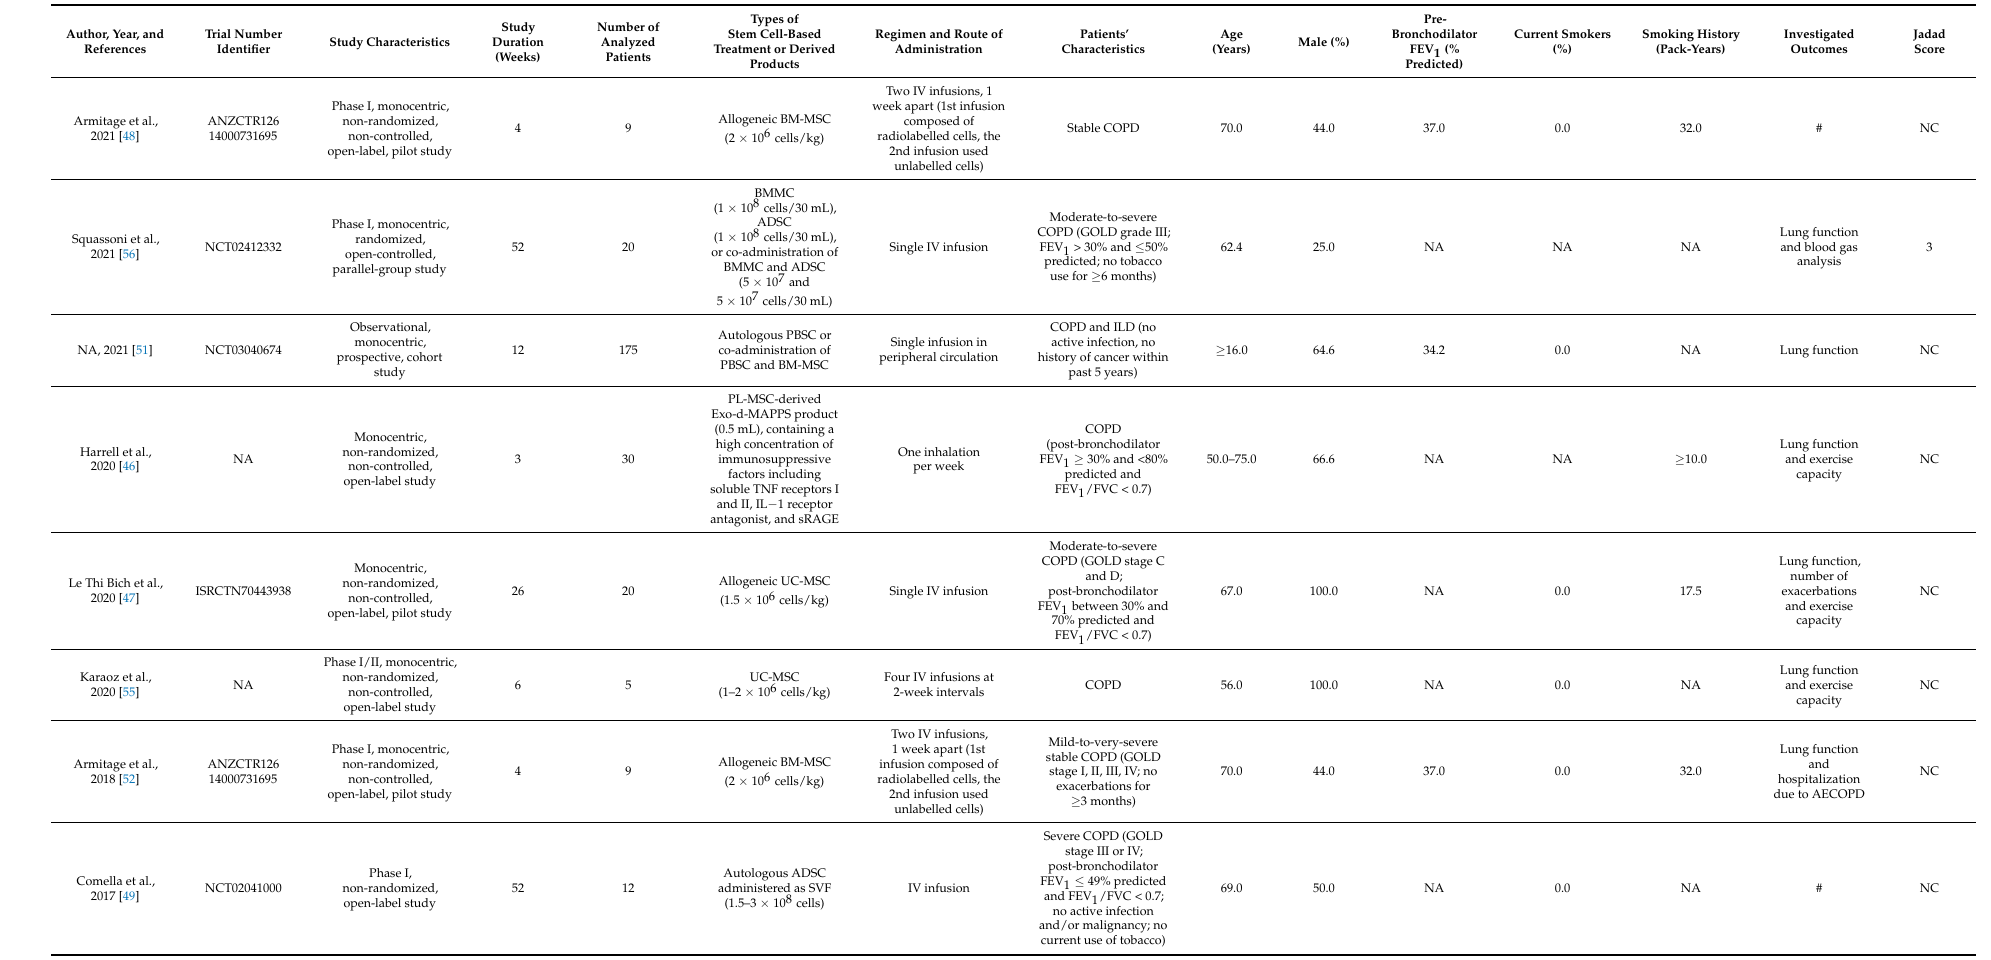
Table 1. Study characteristics of the studies included in the qualitative and/or quantitative